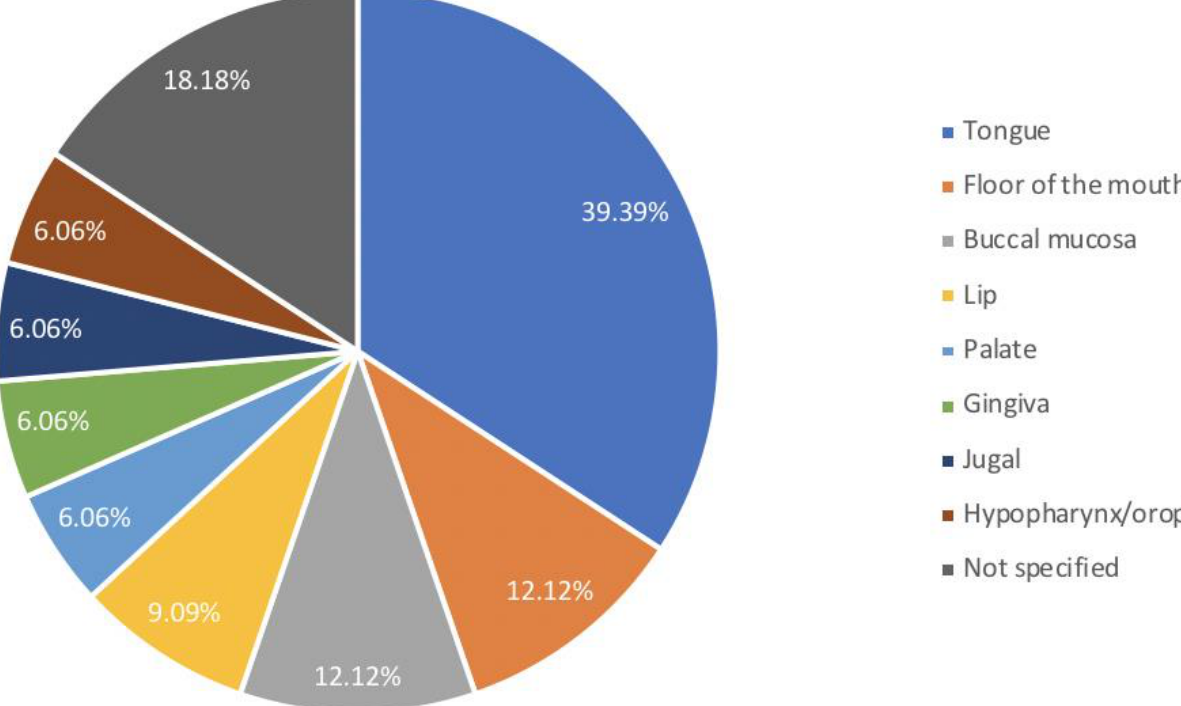
Figure 3. Frequency of involvement of oral sites by oropharyngeal cancer.